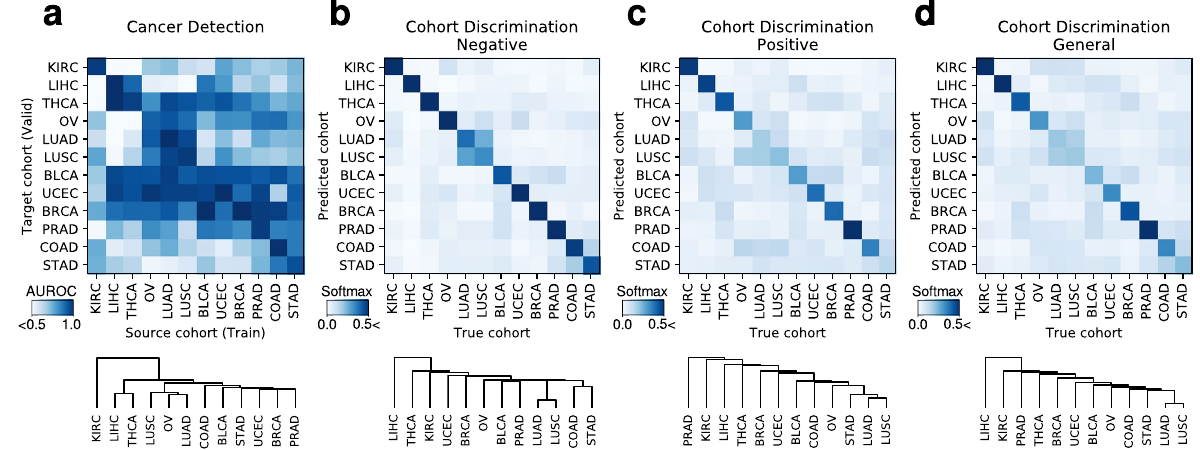
Figure 4. Similarity matrices induced by ( a ) single cohort cancer detection and ( b – d ) cohort discrimination models (top) and their corresponding hierarchical clustering analysis trees (bottom). Single-cohort cancer detection models C ( a ) with columns indicating source (train) cohorts and rows indicating target (validation) cohorts. Negative cohort discrimination model D n ( b ), positive D p ( c ) and general D g ( d ) with columns indicating cohort of origin and rows indicating the model’s